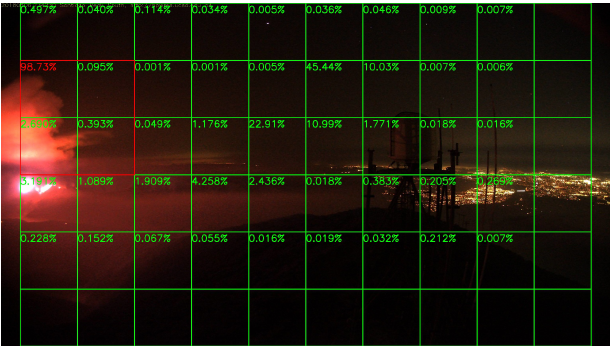
Figure 18. Holy Fire, 6 August